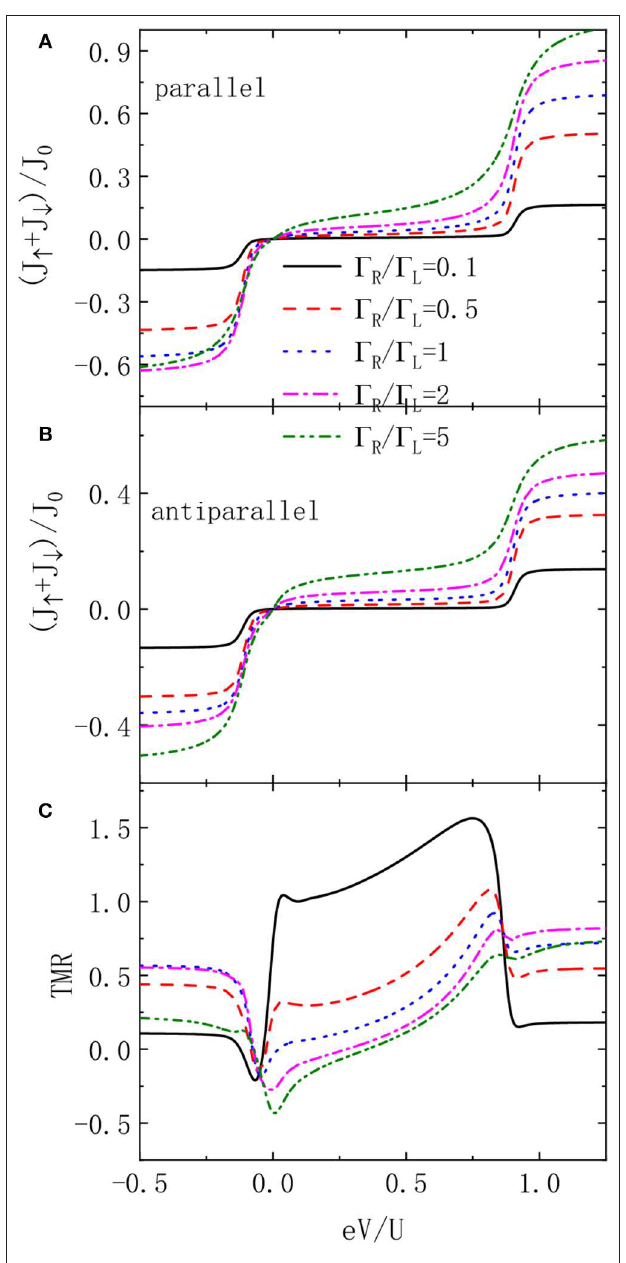
FIGURE 5 | Total currents for parallel (A) and antiparallel (B) configurations, and TMR (C) as functions of the bias voltage for different values of QD-lead coupling asymmetry q with Ŵ 0 0.02 U . Other parameters are as in Figure 2 =